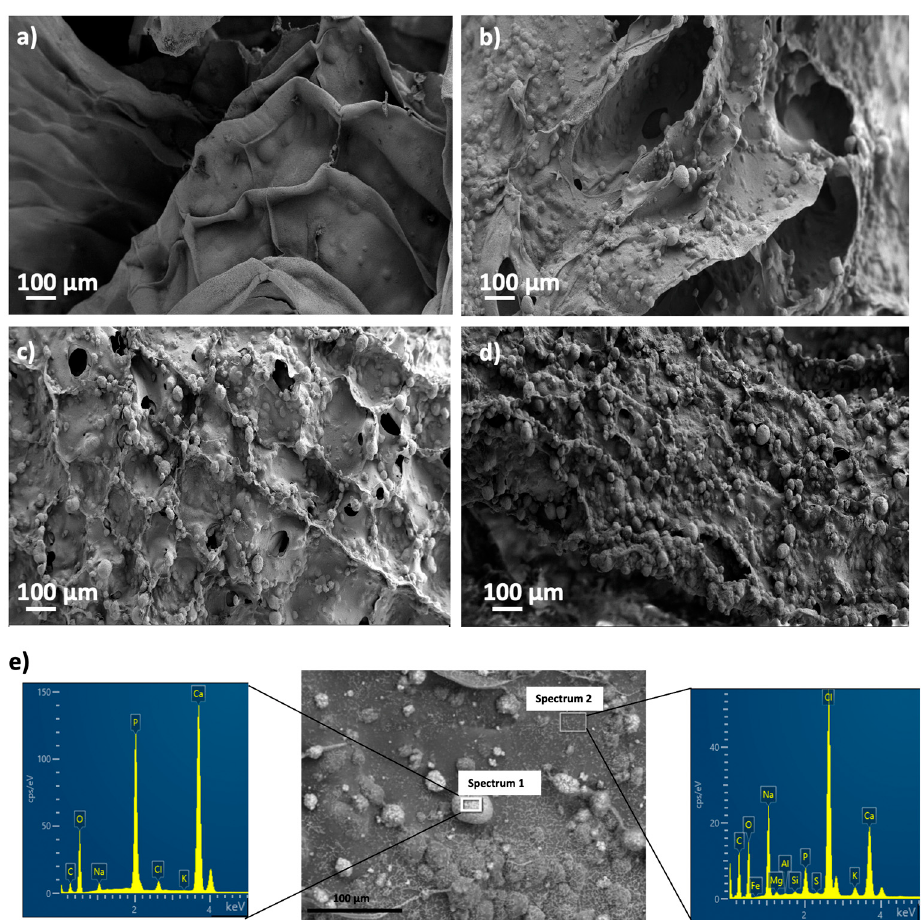
Figure 6. SEM pictures of aerogels printed from alginate 6 wt.% inks and different HA concentrations: ( a ) 0, ( b ) 8, ( c ) 16, and ( d ) 24 wt.%, after bioactivity tests. Aerogels were aged and crosslinked with GA vapor prior to being immersed in SBF medium. ( e ) EDX spectra of Alg 6%, HA 8%, CaCl 2 1M1h GA aerogels after SBF treatment in an apatite granule region (Spectrum 1, left) and a background region (Spectrum 2, right), and representative of all the tested samples.